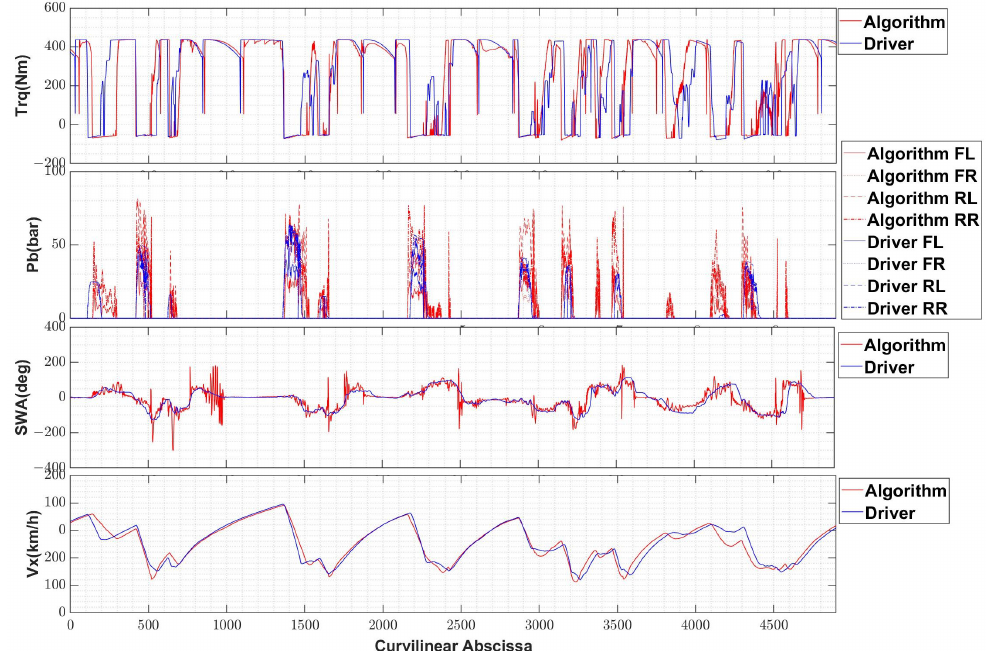
Figure 10. Comparison of the input given to the vehicle and the output longitudinal speed between the algorithm proposed and the